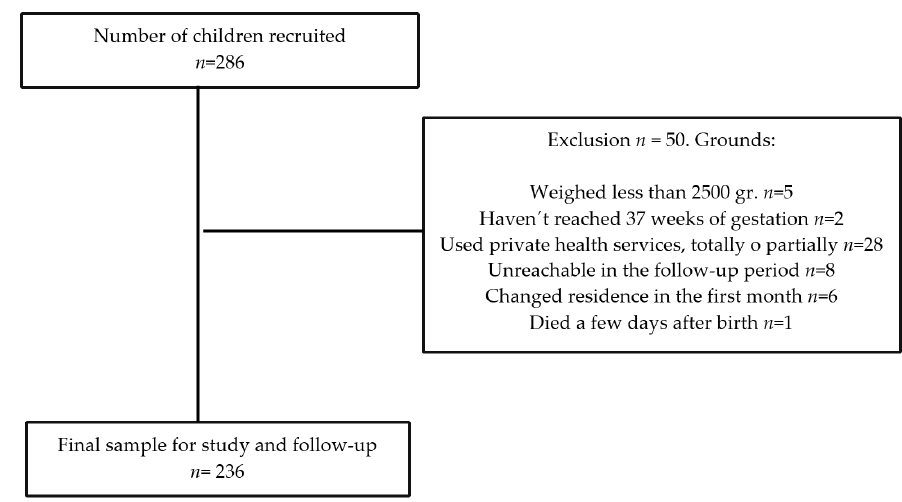
Figure 1. Flowchart of study participants.